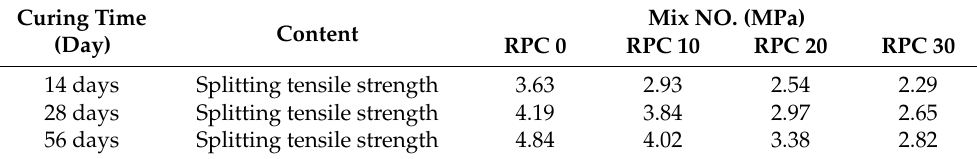
Table 5. Splitting tensile strength of rubber-concrete.